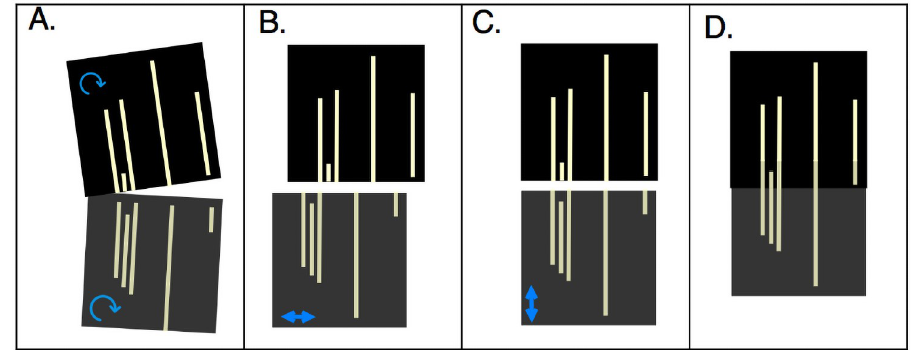
Fig 4. Frame stitching. A simplified illustration of rotation (A), horizontal (B) and vertical (C) translation towards the stitched frames (D).